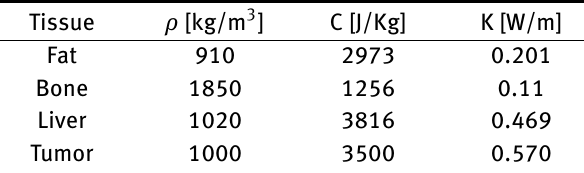
Table 4: Thermal properties of tissue and cancer Tissue